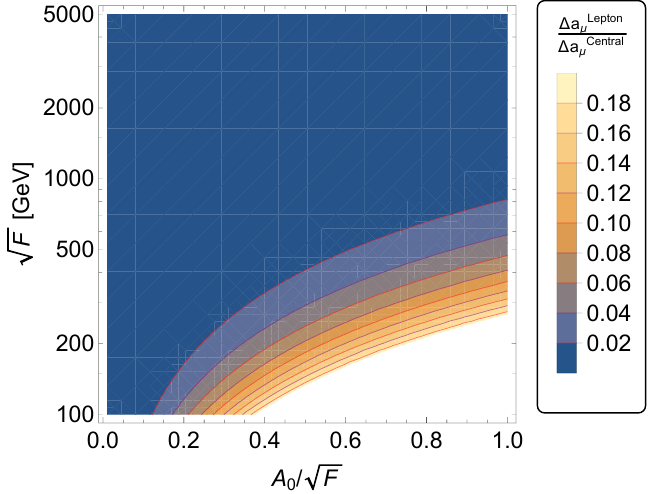
p p F; F ). and (cid:1) a central stand for the contribution (cid:22) (cid:22)